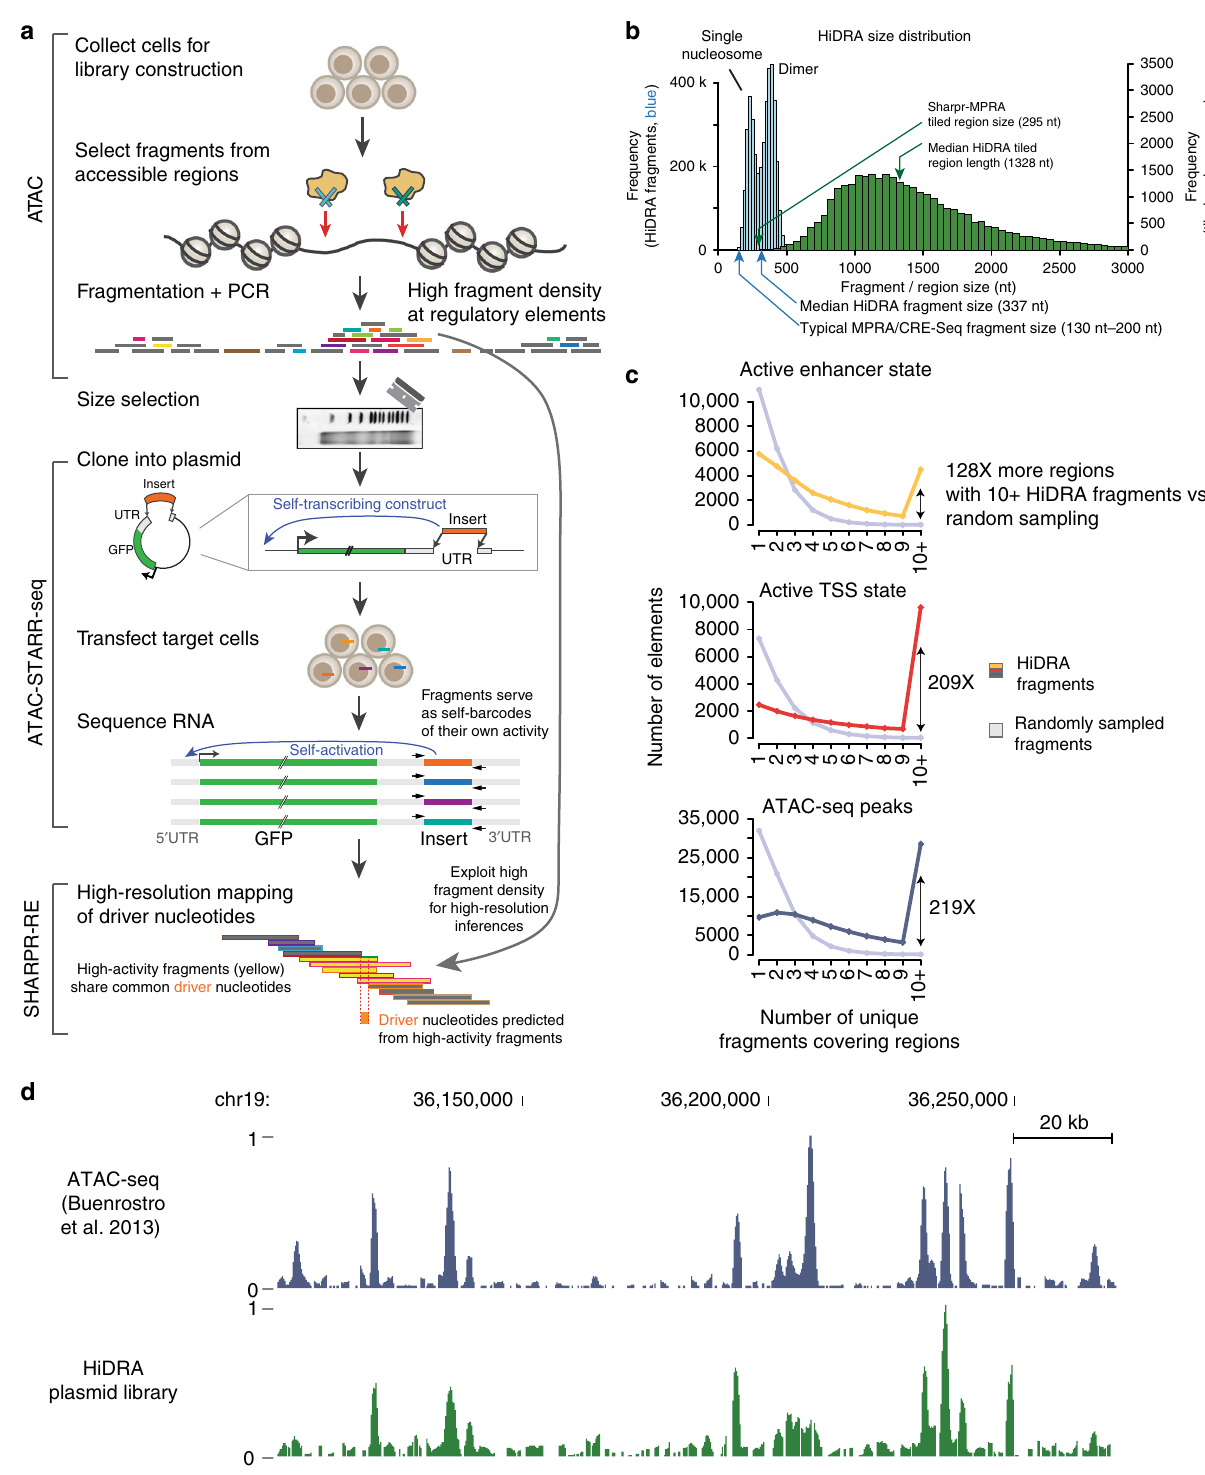
Fig. 1 Overview of HiDRA. a Cells with the desired genotype and open chormatin patterns are selected for library construction. Tn5 transposase is used to preferentially fragment genomic DNA at regions of open chromatin. Fragments are then size-selected on an agarose gel and mtDNA contamination is removed by selective CRISPR-Cas9 degradation. The fragment library is ampli fi ed by PCR and cloned into an enhancer reporter vector. Gel image adapted from Buenrostro et al. 21 . Fragments are cloned into the STARR-seq vector backbone, introduced into target cells (which can differ from cells used to construct the library), and RNA is collected and sequenced. After data processing, the activity of partially-overlapping fragments is compared to identify driver nucleotides using the SHARPR-RE algorithm. b Size distribution of HiDRA library fragments (blue) and tiled regions (green). Bimodal shape for library fragment sizes is due to Tn5 preference to cut adjacent to nucleosomes. Fragment bin size = 20 nt, region bin size = 50 nt. c Number of ChromHMM-predicted active enhancer, active TSS and ATAC-seq peaks covered by multiple unique HiDRA fragments. d HiDRA plasmid library recapitulates the genomic coverage of a conventional ATAC-seq